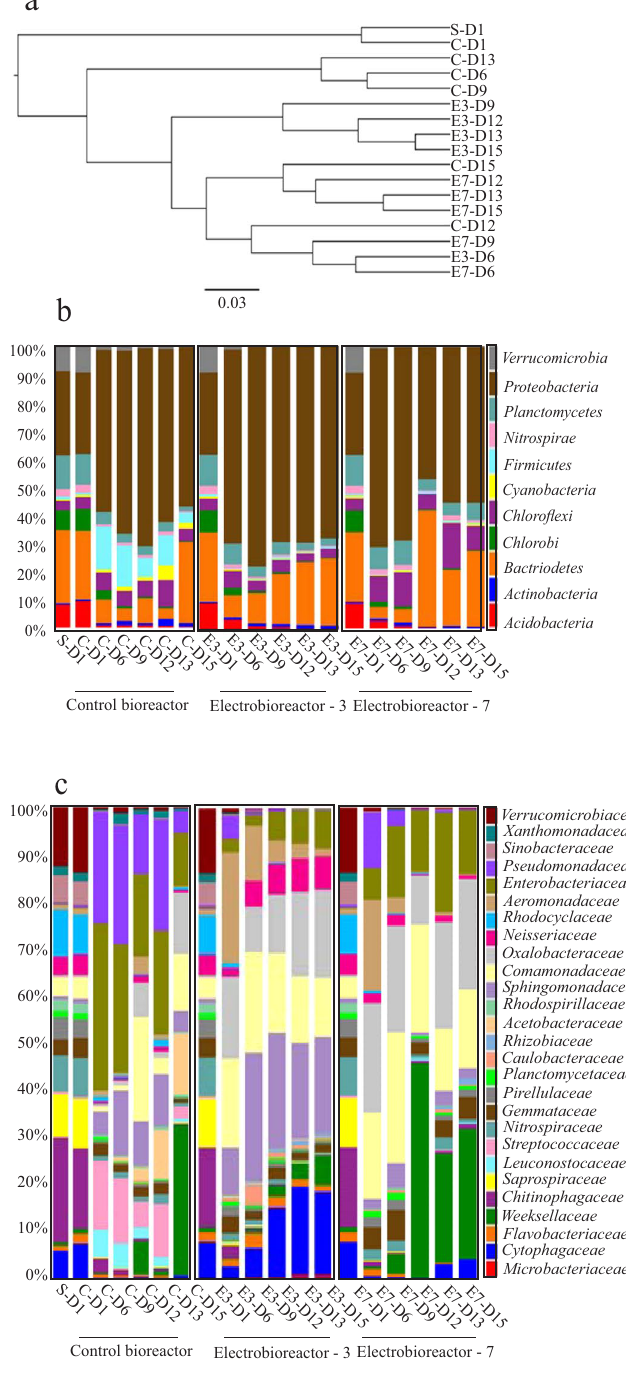
Figure 3. ( a ) Beta-diversity using UPGMA clustering analysis using weighted Unifrac. Phylogeny of the bacterial communities in the control bioreactor and electro-bioreactors at ( b ) phylum level, and ( c ) family level. It is concluded that serial passaged reactors had an impact on microbial community structure and composition in the presence and absence of electric field. (S-D1: Fresh sludge sample without feeding with synthetic wastewater; C-Di: Control sample in day i; E-Dj: Electro-bioreactor sample in day